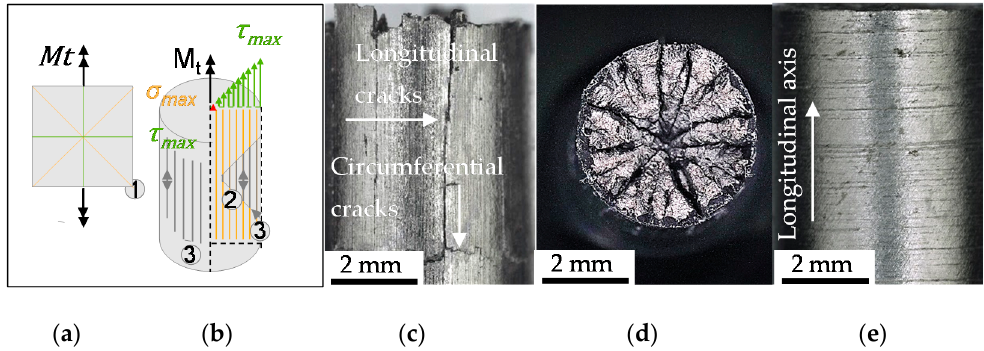
Figure 6. ( a ) General principle schema of the directions of maximal principle stress σ max and maximal shear stress τ max under pure torsional load paths; ( b ) General principle schema of cyclic damage evolution under torsional load paths with the applied torque moment M t ; ( c ) longitudinal cracks in main shear direction and crack coalescence at the circumference; ( d ) crack propagation paths in radial direction; ( e ) divergent failure mechanism induced by cracks in direction of the circumference.